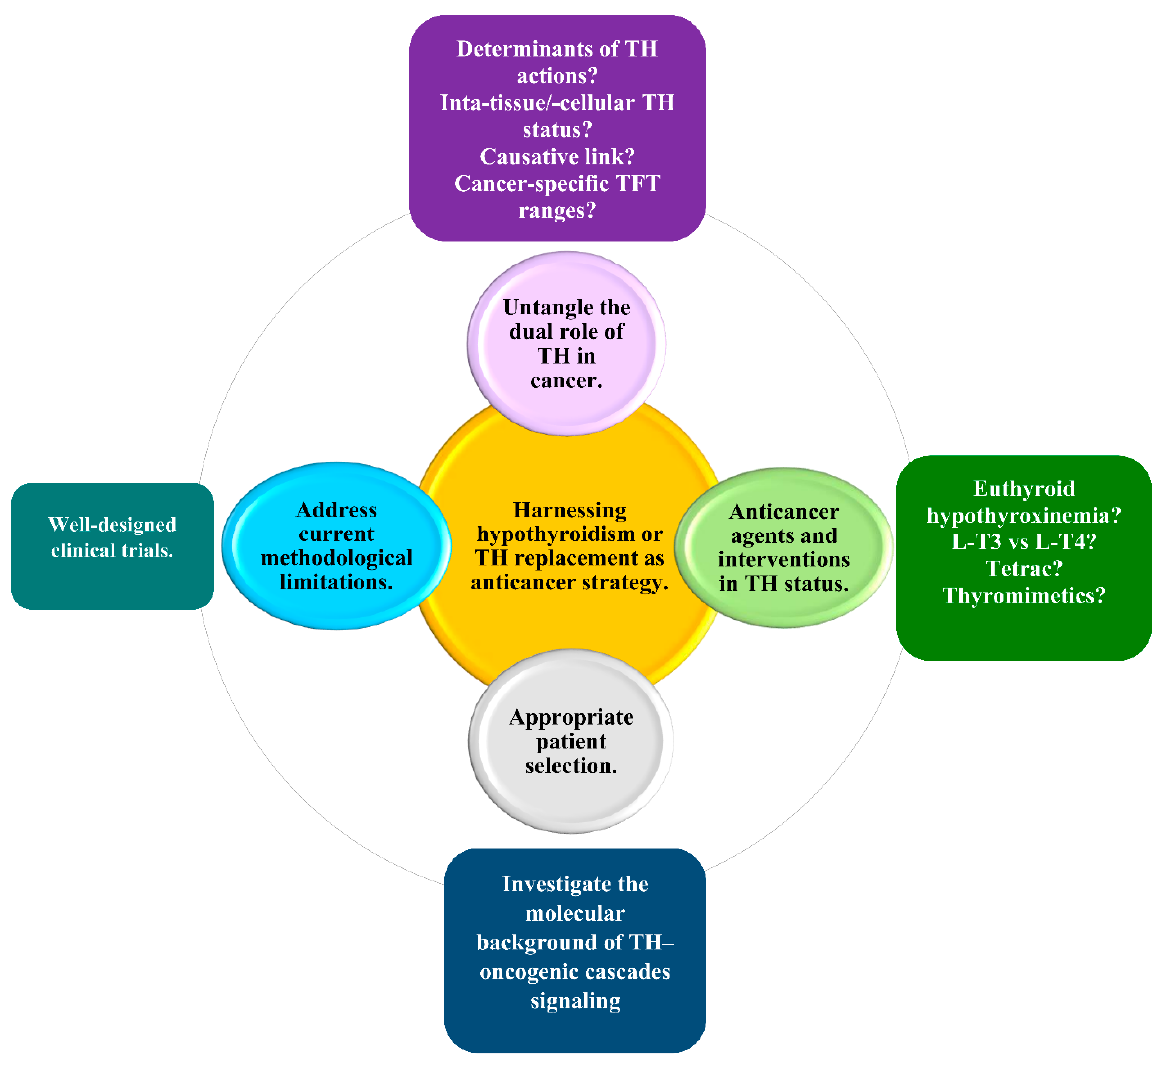
Figure 3. The four prerequisites for harnessing hypothyroidism, or THs replacement, as an anticancer strategy. The four circles represent the four prerequisites for harnessing hypothyroidism, or THs replacement, as an anticancer strategy, and the corresponding rectangles depict current challenges and future perspectives arising from each of these prerequisites. Abbreviations: THs, thyroid hormones; L-T3, liothyronine; L-T4, levothyroxine.